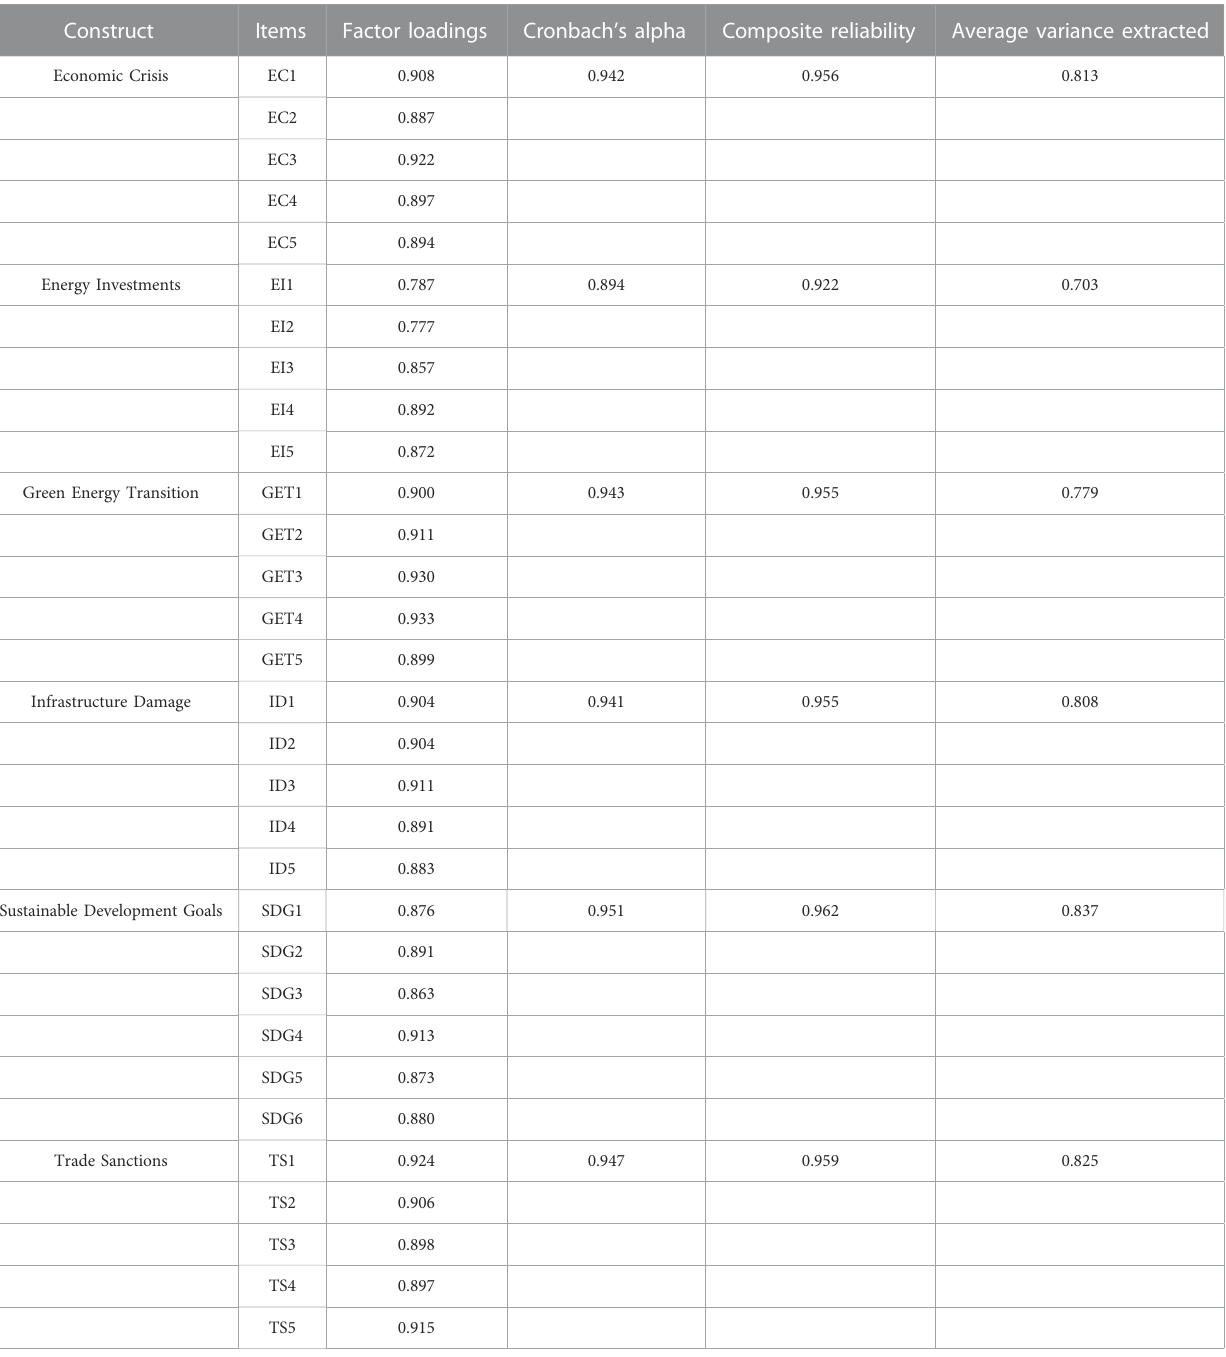
TABLE 3 Convergent validity.